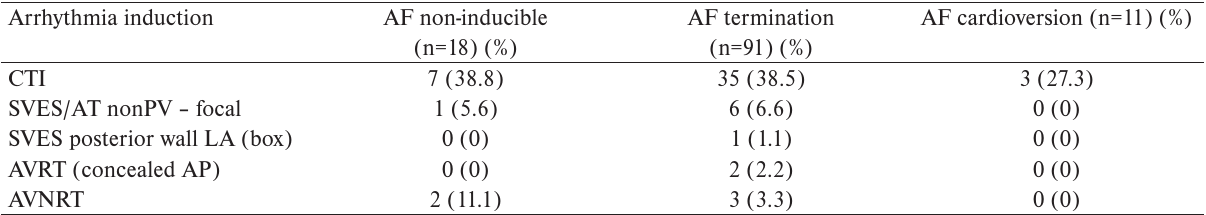
Table 1. Arrhythmias inducible in individual subgroups.